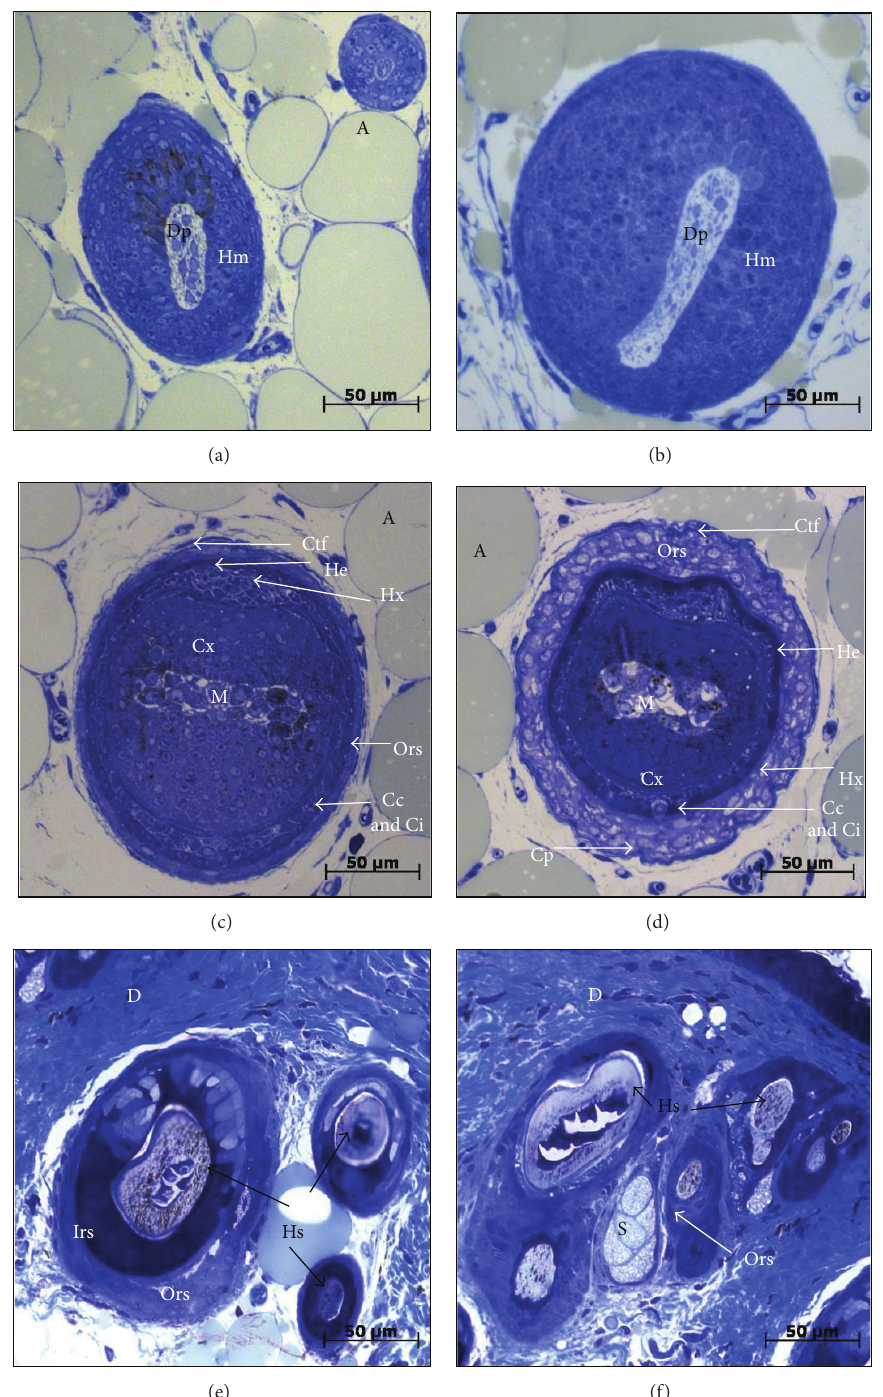
Figure 5: Photomicrograph of the hair follicles in the young adult four-striped mice at different levels. (a) and (b) are at the hair bulb level. (a) shows two hair follicles of small and intermediate sizes. (b) is a large follicle compared to (a). (c) shows a large follicle sectioned at the suprabulbar level, in the hypodermis. (d) is a large follicle at a level slightly higher than the suprabulbar level, in the hypodermis. (e) is follicles, in the superficial hypodermis to basal dermis. (f) shows follicles in the dermis at, or above, the sebaceous gland. A: adipocytes; Cc: cuticle of cortex; Ci: cuticle of inner root sheath; Cp: companion layer; Ctf: connective tissue follicle; Cx: cortex; D: dermis; Dp: dermal papilla; He: Henle’s layer; Hm: hair matrix; Hs: hair shaft; Hx: Huxley’s layer; Irs: inner root sheath; M: medulla; Ors: outer root sheath; S: sebaceous gland. Toluidine blue staining. Scale bar: 50 𝜇